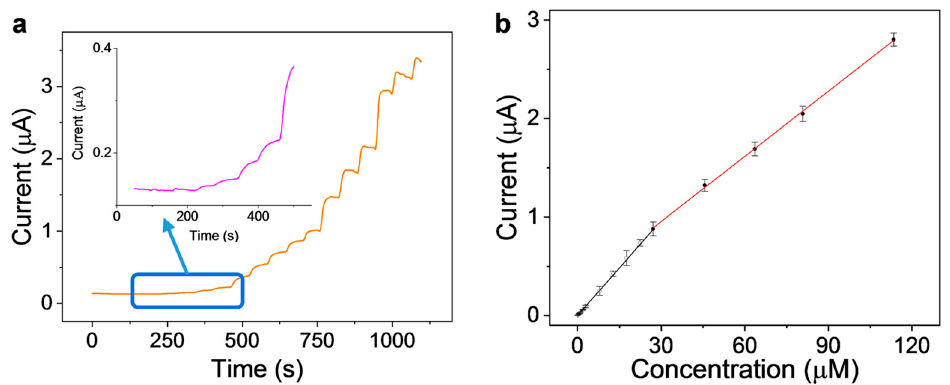
Figure 4. Analytical performance of CeVO 4 /MWCNTs-GCE. ( a ) Amperometric current-time response curve obtained by the successive addition of different concentrations of SMZ; ( b ) anodic current versus SMZ concentration plot.